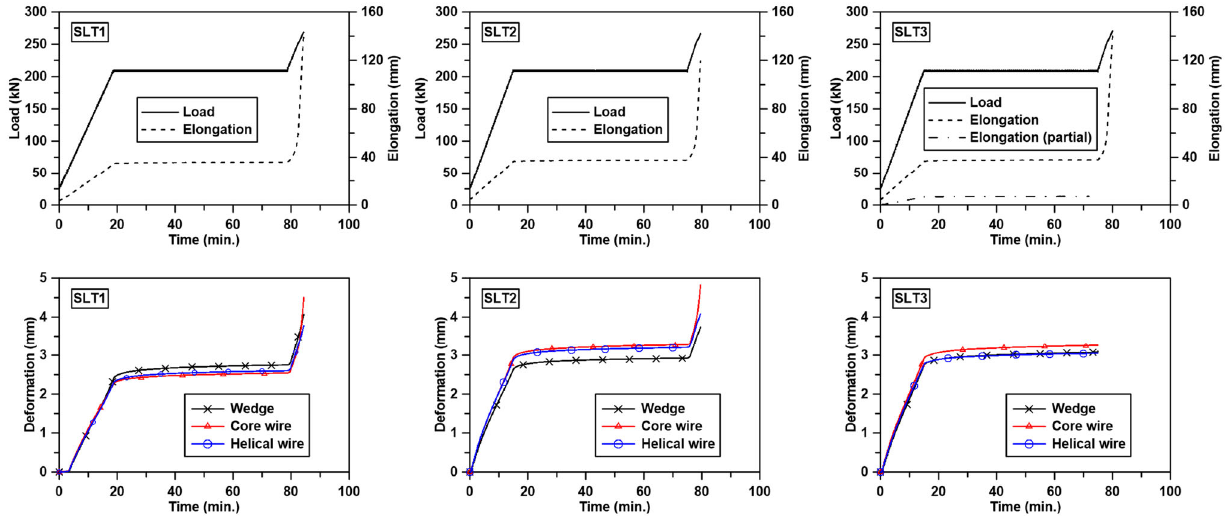
Fig. 7 Results of static load